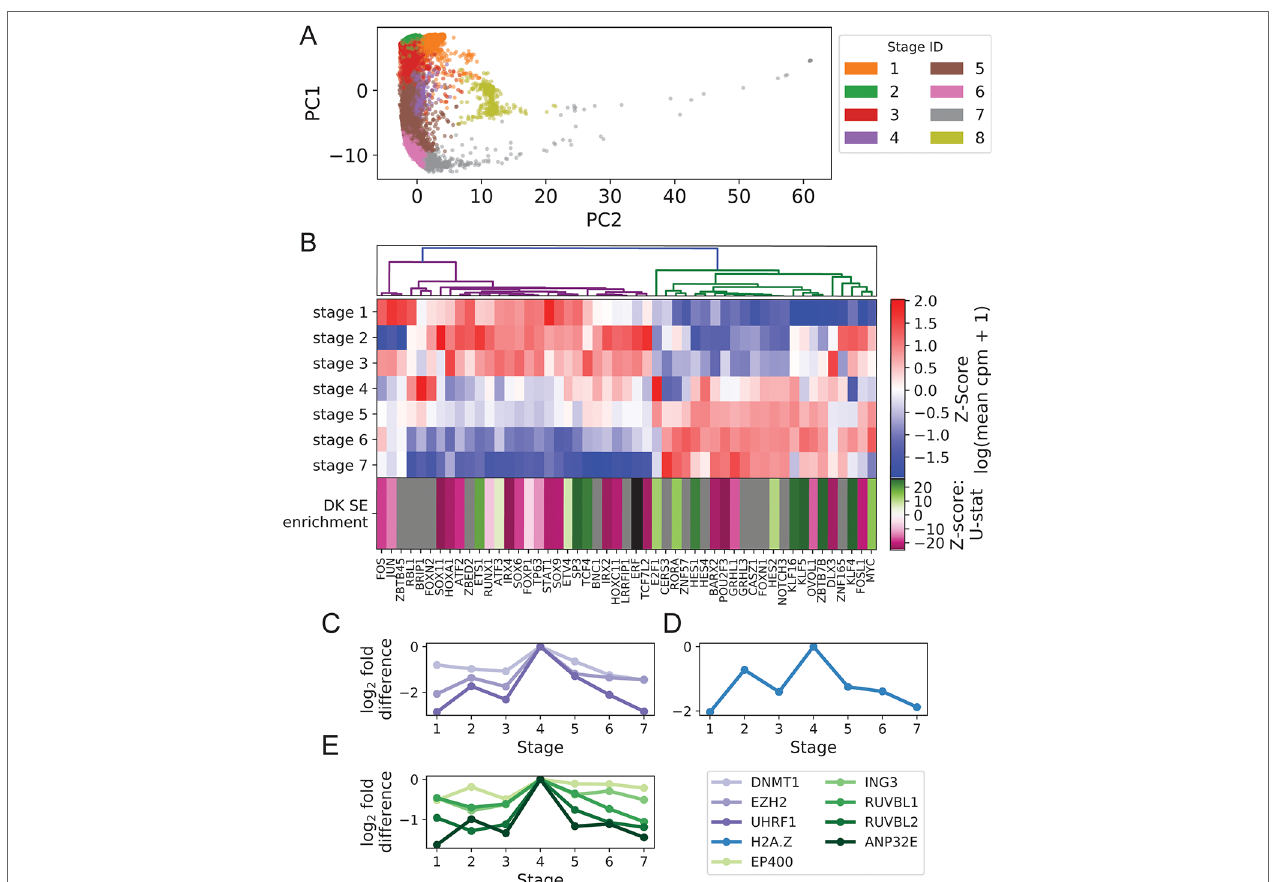
FIGURE 1 | Turnover in Keratinocyte TF expression is temporally and spatially coupled to turnover in SEs. (A) Imputed single-cell expression vectors of 22,338 foreskin keratinocytes projected onto first two principal components; stage membership was assigned by k-means–based approximate spectral clustering. (B) First seven rows show log-transformed stage-wise mean imputed expression of dynamic Keratinocyte TFs normalized across stages. Bottom row shows the magnitude and direction of differential motif enrichment between BK and DK SEs. Gray and black cells correspond to TFs without a known binding motif and TFs not differentially enriched between SE sets, respectively. Columns are organized by hierarchical clustering on first seven rows (Methods). (C−E) Log fold-change in stage-wise mean imputed expression between stage 4 (mitotic state) and other stages for established keratinocyte epigenetic regulators (C) , H2A.Z (D) , and a subset of components of SWR1 remodeler complex (E) . See also Supplementary File 1 : Figures S1−4